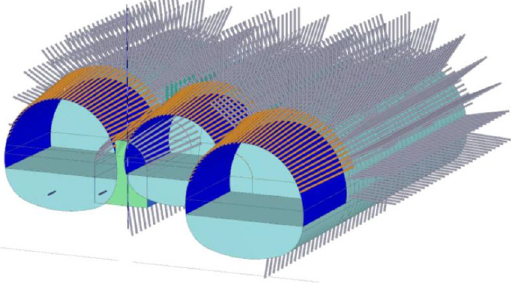
Figure 12. Excavation of the eastbound and westbound tunnels and the knocking out of rock bolts and shotcrete in the pilot tunnels.